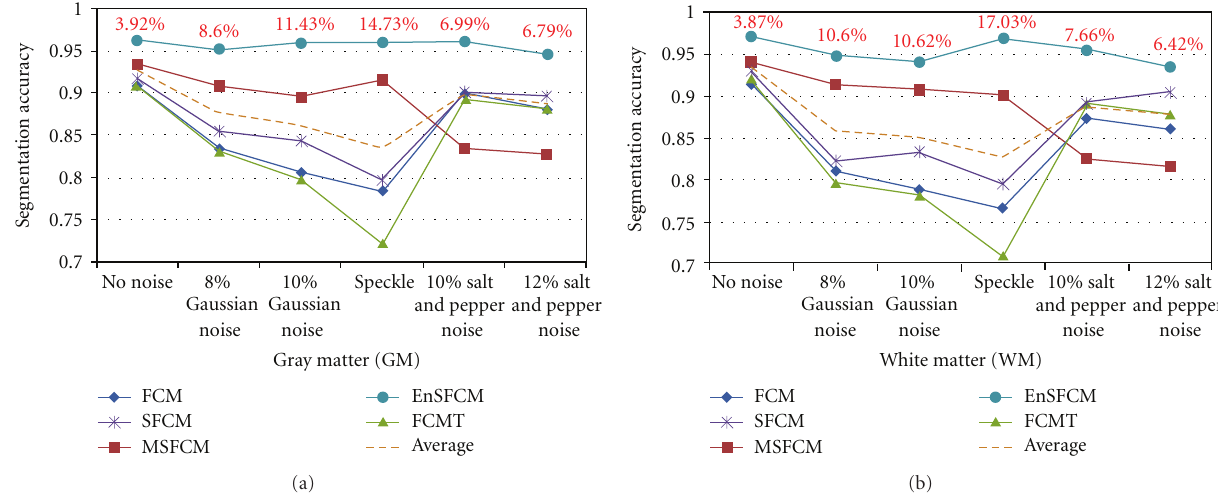
Figure 5: Segmentation accuracy results for gray matter (GM) and white matter (WM) in noisy environment by using FCM, MSFCM, FCMT, SFCM, and the proposed segmentation